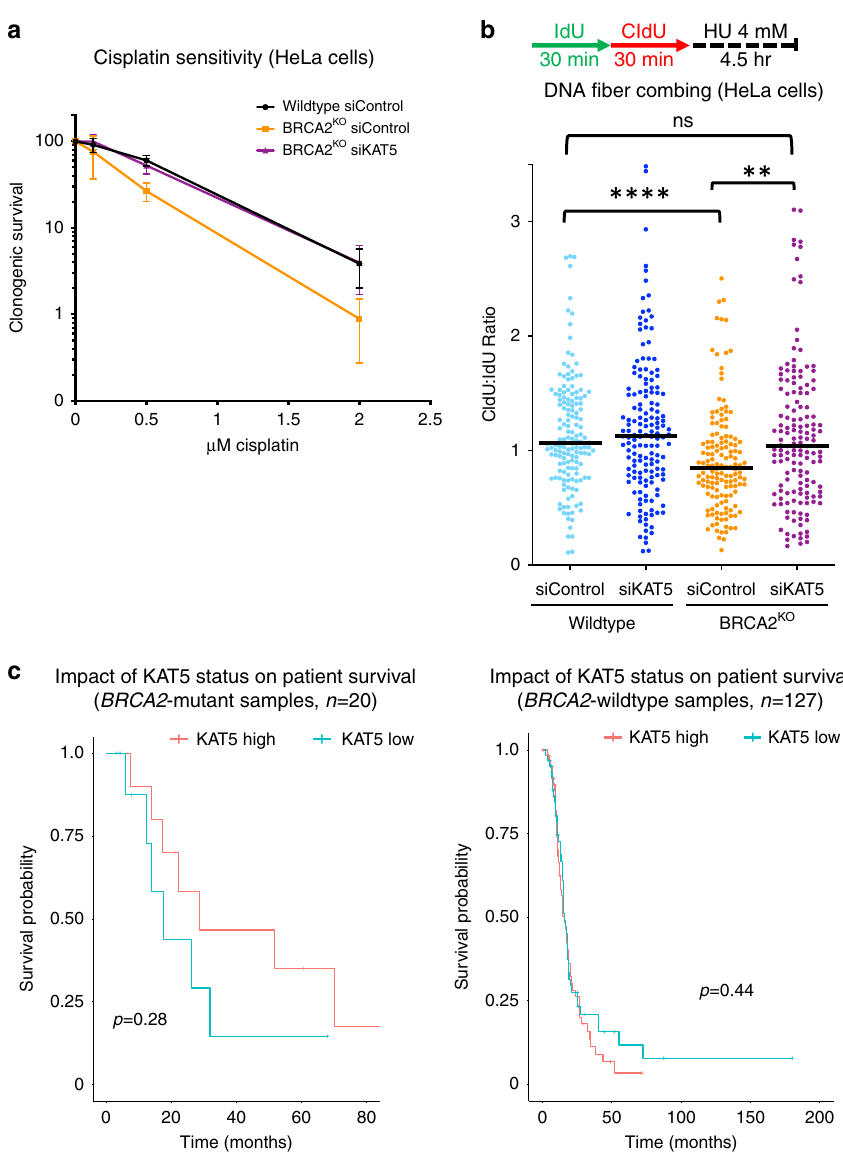
Fig. 7 Loss of KAT5 expression causes resistance to cisplatin in BRCA2-de fi cient cells. a In clonogenic survival assays, depletion of KAT5 in BRCA2- knockout HeLa cells led to increased colony formation after cisplatin treatment (24 h). The averages of three experiments are shown, with standard deviations as error bars. b DNA fi ber combing assay showing that KAT5 depletion partially suppresses the HU-induced nascent DNA degradation in BRCA2-de fi cient cells. The ratio of CldU to IdU tract lengths is presented, with the median values marked on the graph. At least 150 replication tracts were quanti fi ed for each sample. Asterisks indicate statistical signi fi cance (Mann – Whitney test, two-sided). c Bioinformatic analysis of the OV-TCGA dataset shows that patients with tumors that have low KAT5 expression trend towards poorer survival in BRCA2 mutant (left) but not BRCA2 wildtype (right) tumors. The difference in BRCA2 mutant samples is not signi fi cant ( p = 0.28) likely because of the small number ( n = 20) of BRCA2-mutant samples in this dataset. Source data are provided as a Source Data fi